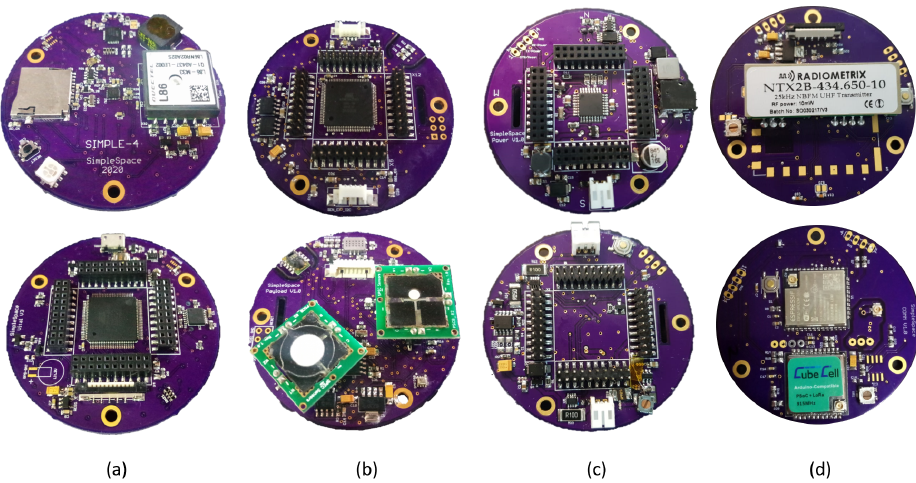
Figure 6. ( a ) SimpleVital (Command On Board & Data Handling (CB&DH)), ( b ) SimplePayload (Gases/Pollution), ( c ) SimplePower (Energy Power Supply (EPS)), ( d ) SimpleCOMM (Communica- tions Subsystems